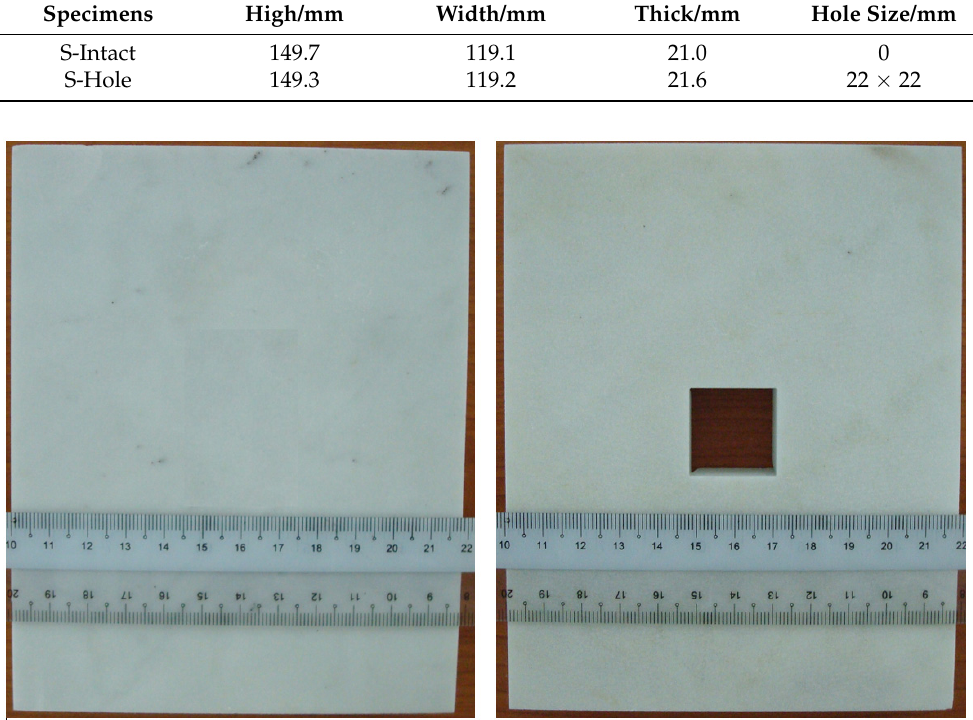
Table 1. Instron-1346 hydraulic servo control testing machine was used for uniaxial com- pression test. The loading strain rate was 2 × 10 − 5 , which belonged to quasi-static loading.